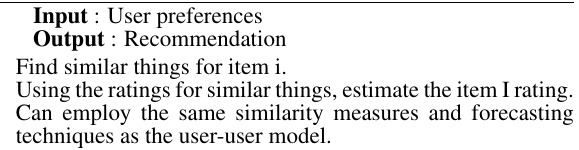
Algorithm 2 Item-based collaborative filtering algorithm.